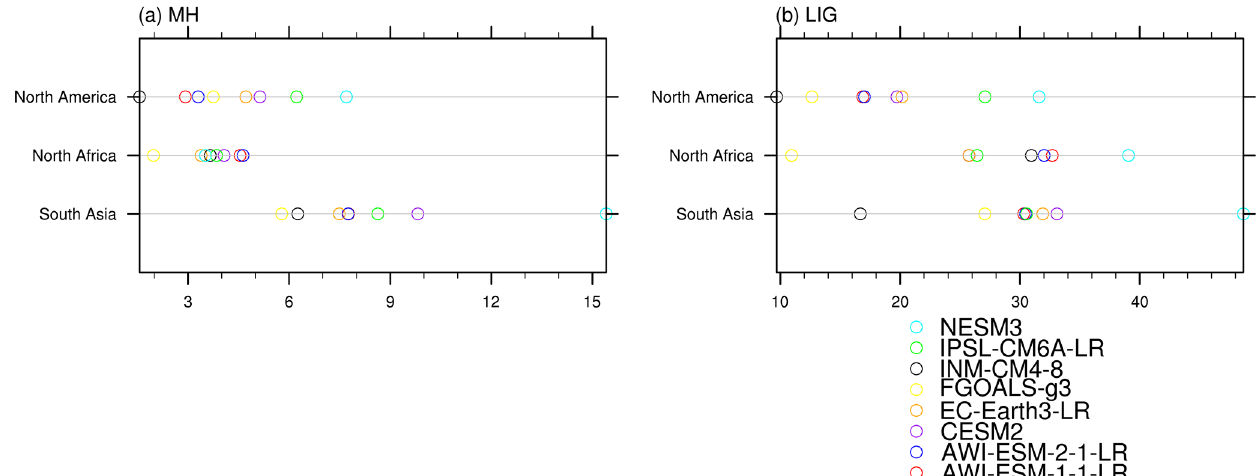
Figure 9. (a) Deviation of SON MH-PI precipitation between angular and classical means for North America, northern Africa, and South Asia, simulated by individual models. (b) As in (a) , but for LIG-PI precipitation. Units: mm per month.